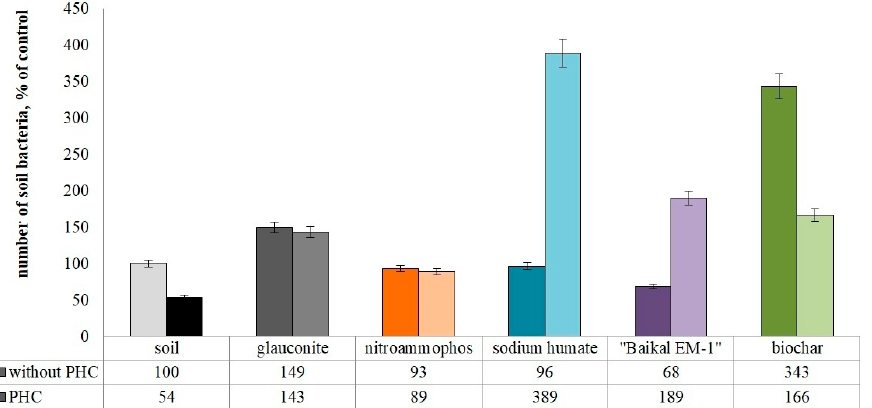
Figure 7. Change in the number of soil bacteria in non-contaminated and petroleum hydrocarbon-contaminated Haplic Chernozem Calcic after the introduction of bioremediators, % of control. Note: PHC, petroleum hydrocarbon.